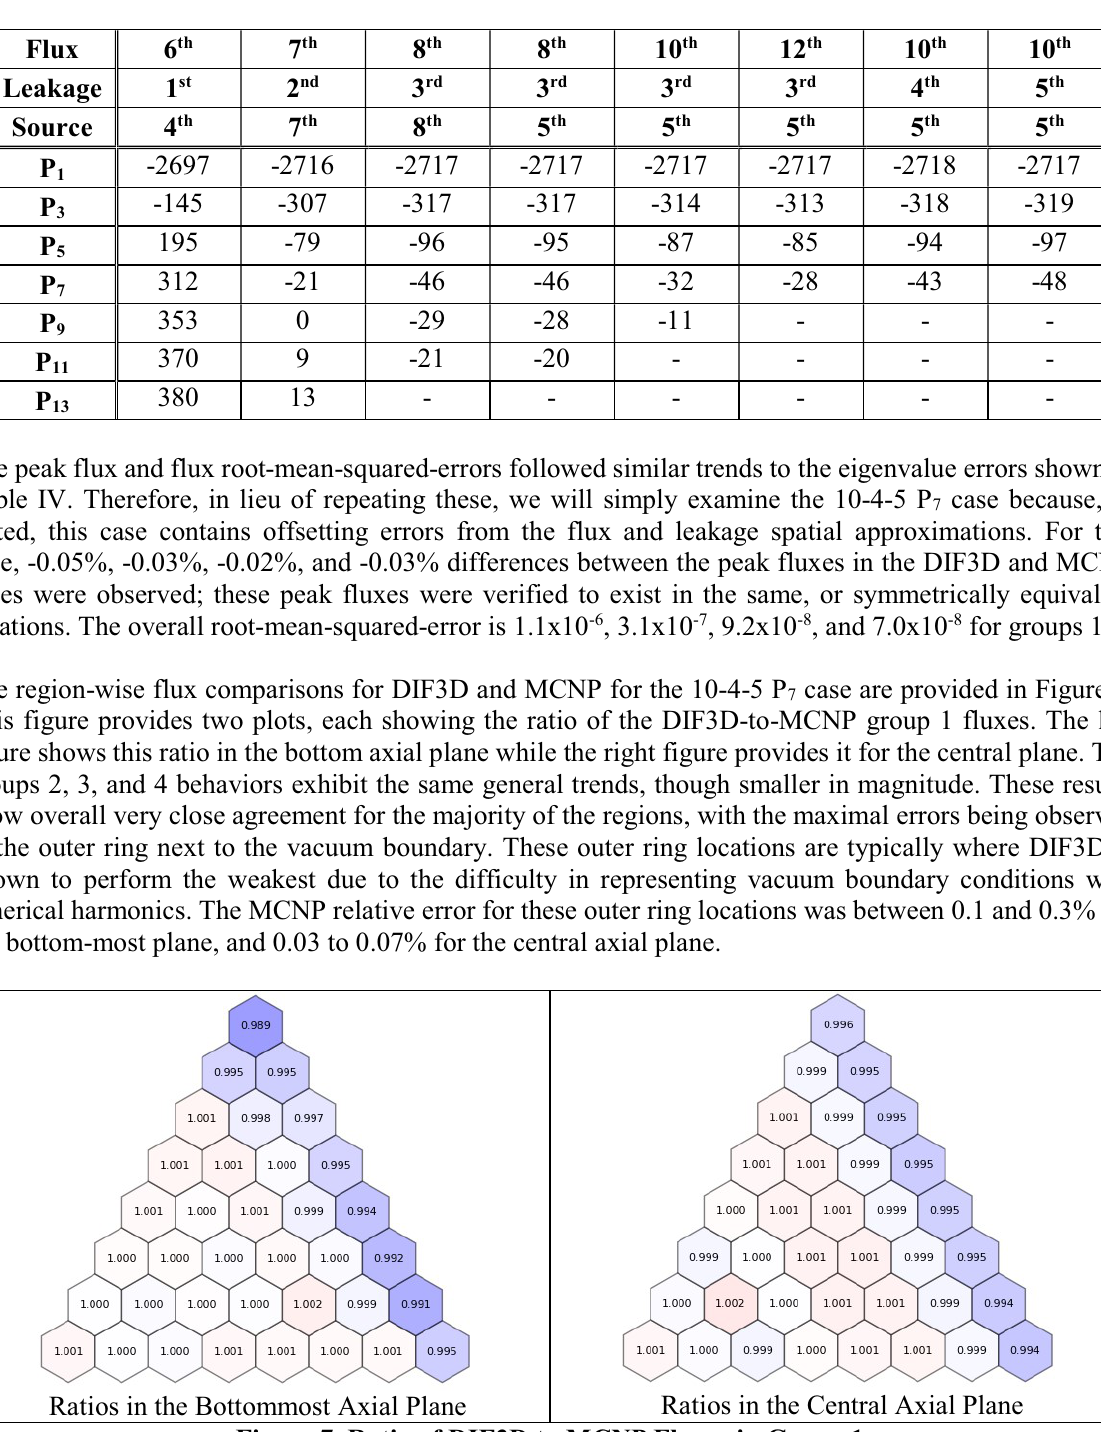
Table IV. Takeda 4, Rods-In, Eigenvalue Errors in Units of pcm